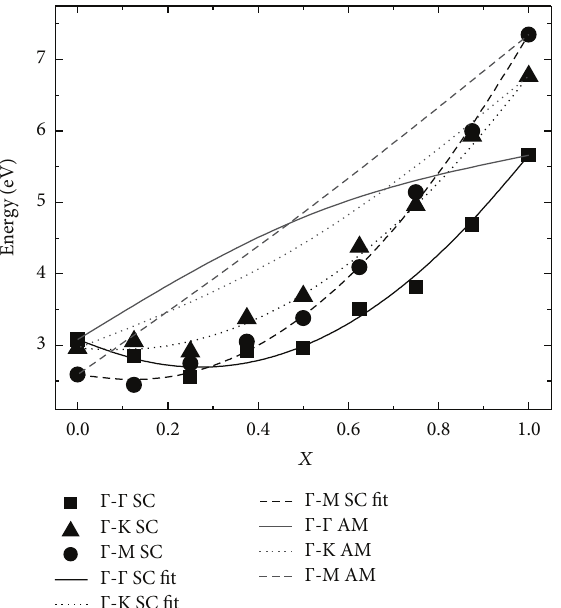
Figure 6: Composition dependence of different band gaps for the wurtzite structure (WZ). Filled points represent the supercell (SC) alloy simulation with black lines representing their parabolic fit. Grey thin lines relate to the alchemical mixing